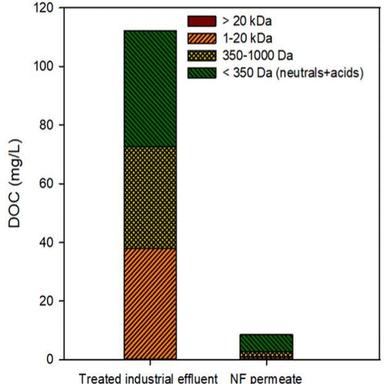
Removal of individual groups of hydrophilic dissolved organic carbon (DOC) based on the molecular weight, including higher than 20 kDa, 1–20 kDa, 350–1000 Da, and lower than 350 Da (neutrals + acids) in the rubber and plastic (RP) industrial wastewater treatment plant (IWTP) through the NF process. Samples were collected and measured in October 2020.